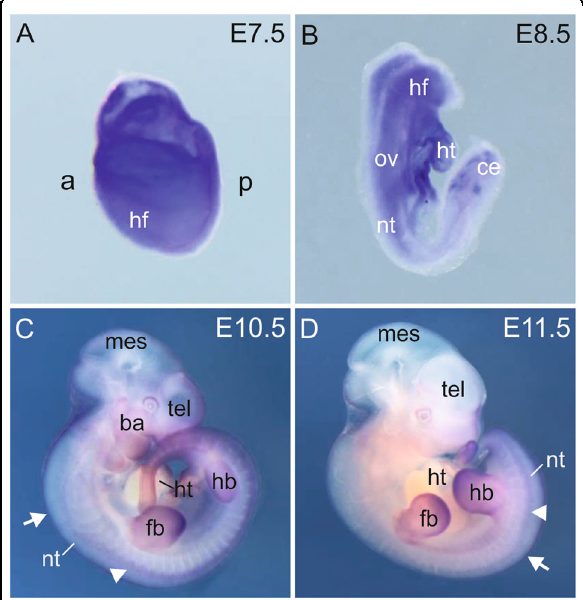
Fig. 1 Wwc2 expression in mouse embryos from E7.5 to E11.5. Spatial expression of Wwc2 mRNA in E7.5 ( A ), E8.5 ( B ), E10.5 ( C ), and E11.5 ( D ) mouse embryos. White arrowheads mark expression in dorsal root ganglia, white arrows show expression in the roof plate of the neural tube. From E8.5 onwards extraembryonic membranes were removed. a anterior, ba branchial arches, ce caudal end, fb forelimb bud, hf head fold, ht heart anlage, hb hindlimb bud, nt neural tube, mes mesencephalon, ov otic vesicle, p posterior, tel